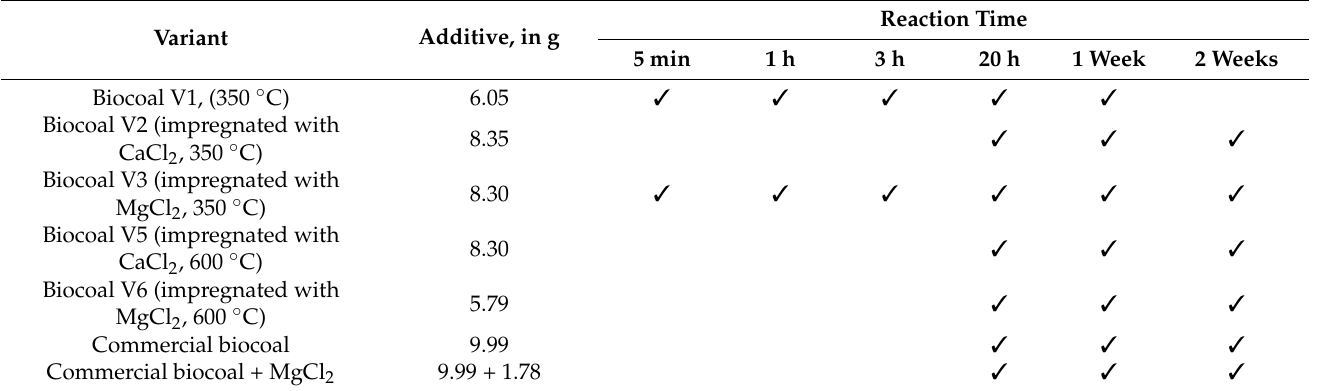
Table 1. Experimental design of the digestate pretreatment with additives. The check marks indicate the experiments performed. The added amounts corresponded to 1.2 kg of the